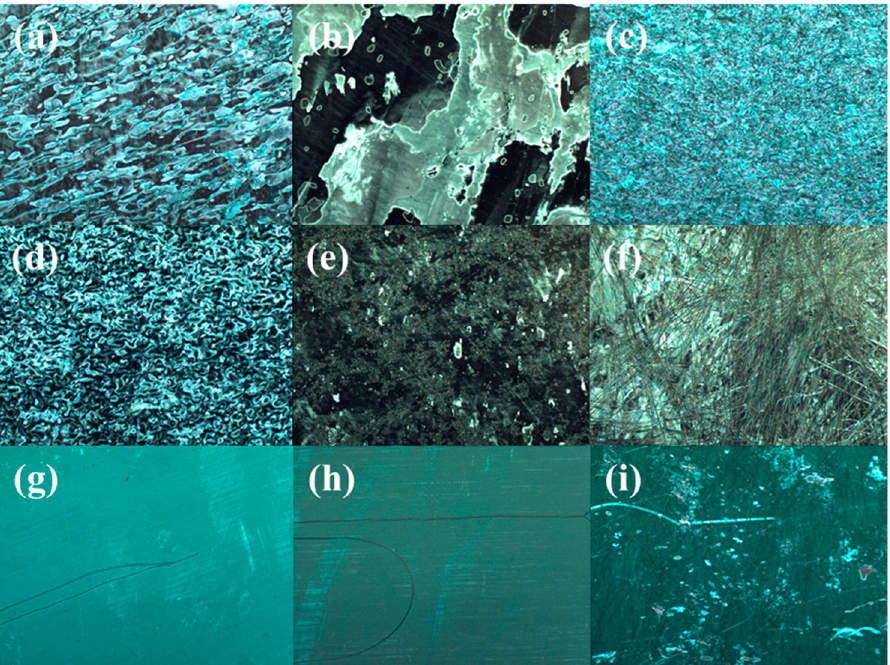
Figure 2. POM images of ( a ) androsterone, ( b ) cholic acid, ( c ) epiandrosterone, ( d ) hydrocortisone, ( e ) prednisone, ( f ) stigmasterol, ( g ) β -estradiol, ( h ) cholesterol, and ( i ) progesterone at 5 wt. % in E7 .